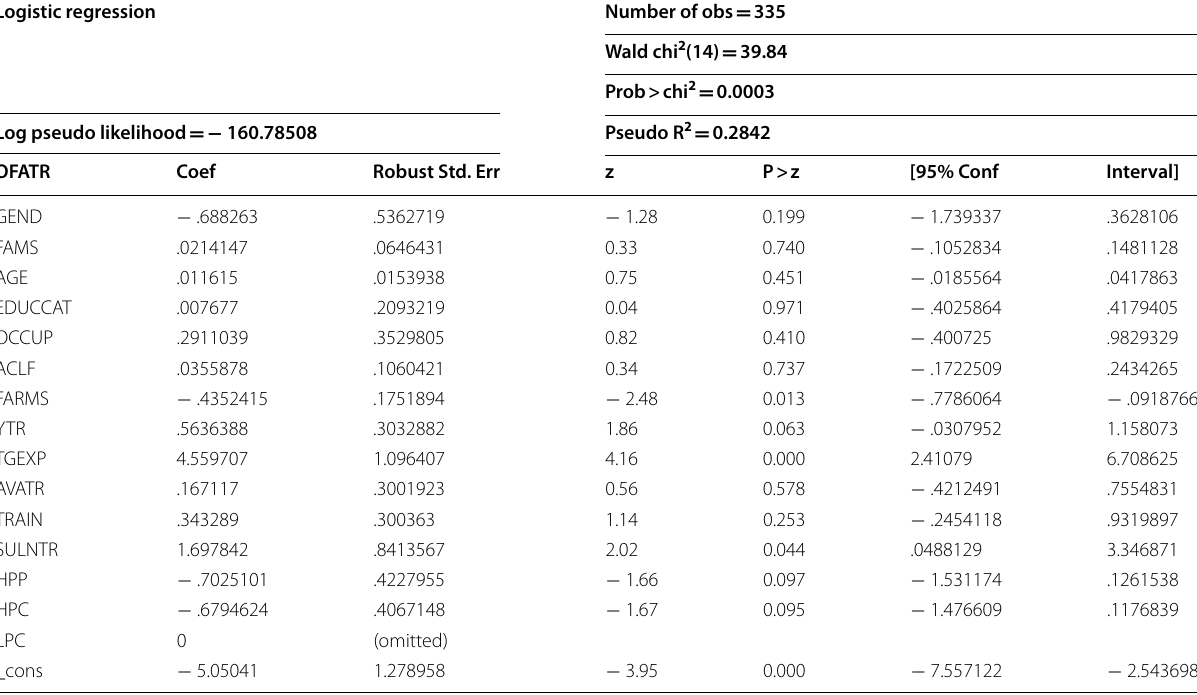
Table 9 Estimates of logistic regression with agro-ecological